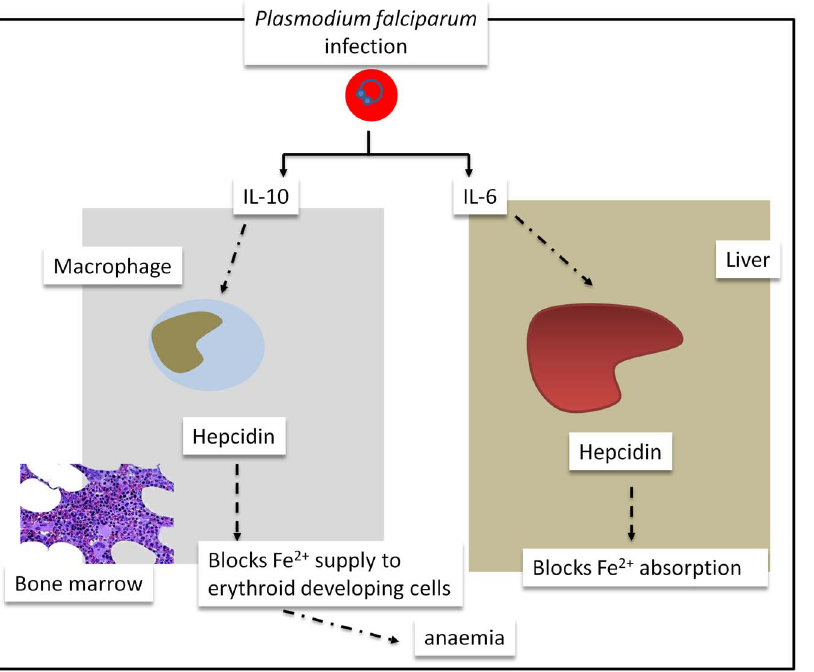
Figure 4. Proposed model of hepcidin in malaria infection. The regulation of hepcidin in response to infection may vary with cell type. A major response to infection occurs in hepatocytes in response to IL-6. However, our observations support the role of IL-10 in primary macrophages. Availability of iron to erythroid developing cells ultimately depends on macrophages and thus the high concentration of IL-10 may play a key regulatory role. Indeed, actively dividing cells like those found in the bone marrow are more susceptible to oxidative damage. In this context, both the direct anti-inflammatory effect of IL-10 and its indirect effect on iron restriction through the up-regulation of hepcidin may be beneficial.